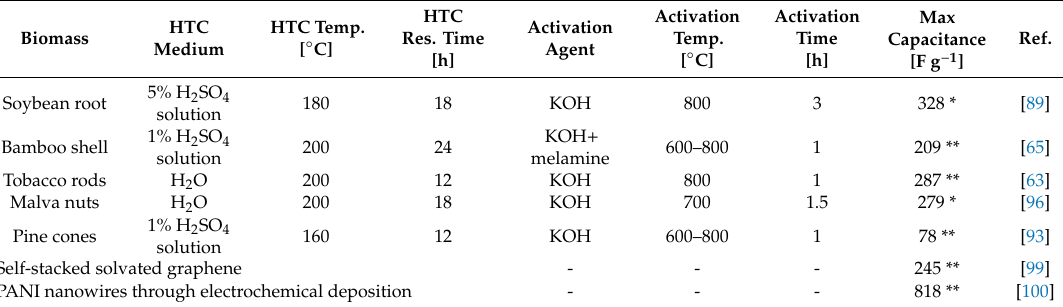
Table 2. Performances of biomass-derived hydrochar for supercapacitors